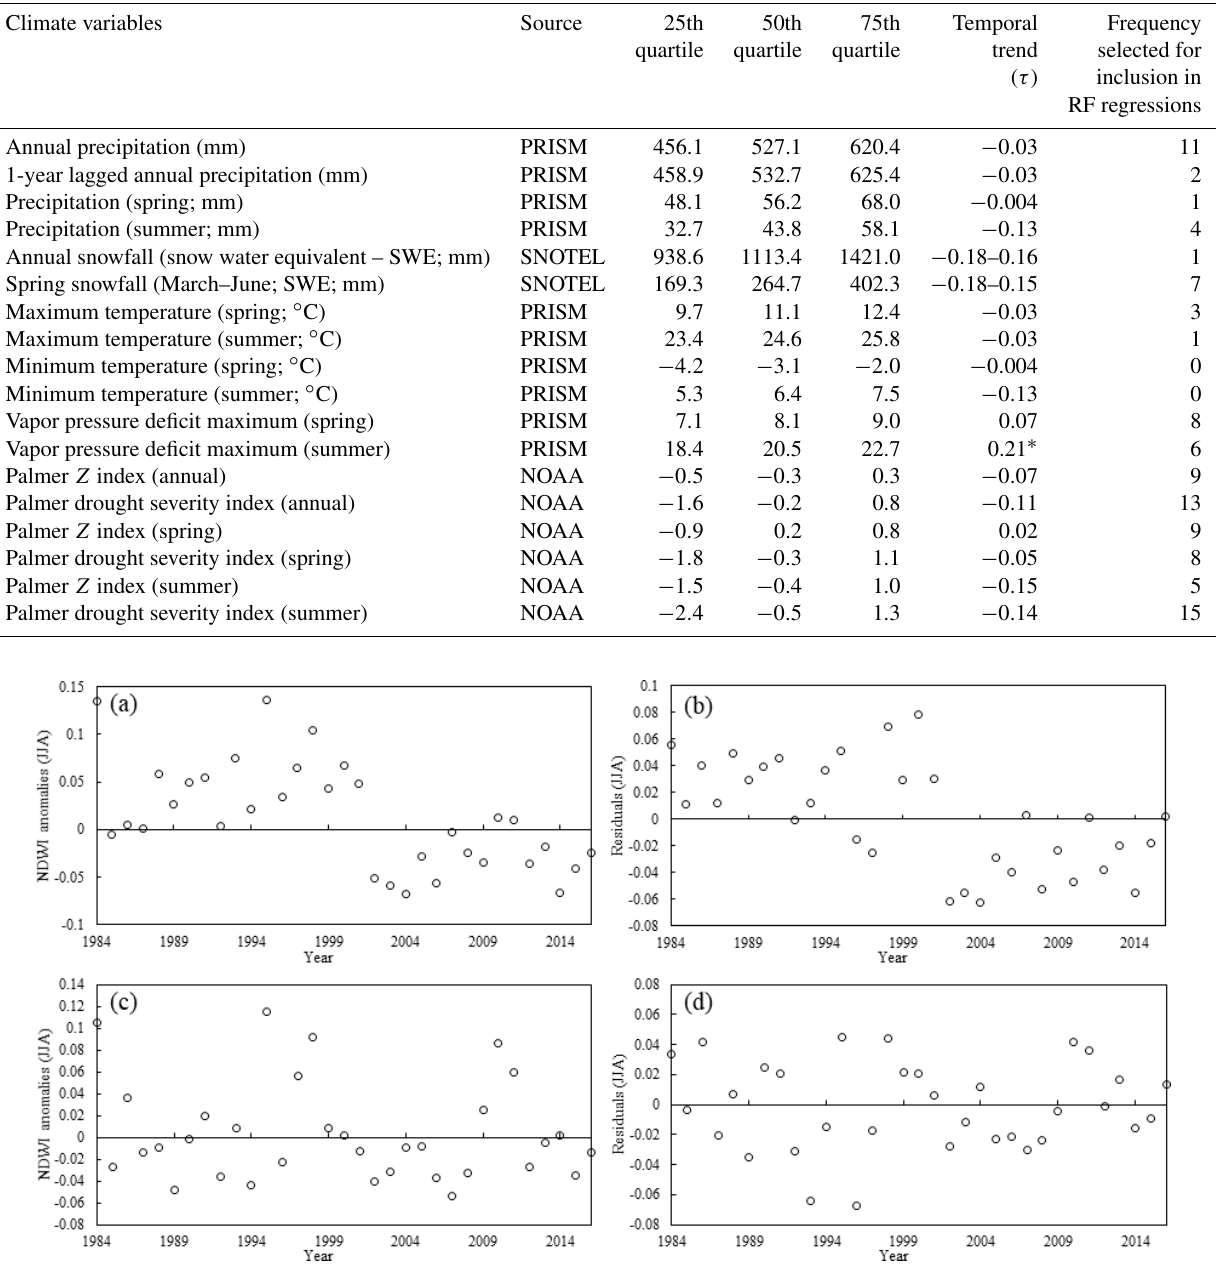
Figure 9. The Beaverhead River (BVHR4) (a) NDWI anomalies over time and (b) NDWI anomaly–climate regression residuals over time. The Beaverhead River (BVHR2) (c) NDWI anomalies over time and (d) NDWI anomaly–climate regression residuals over time. The MK test for trends was significant ( p < 0 . 05) for (a) and (b) but not significant for (c) and (d) . JJA: June, July and